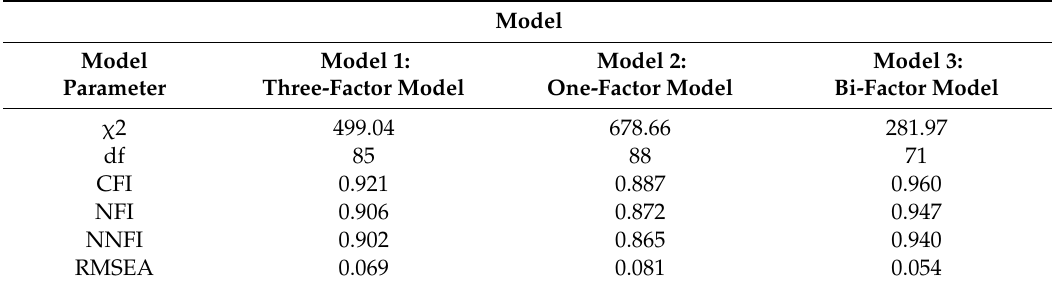
Table 2. Fit indices for confirmatory factor models.